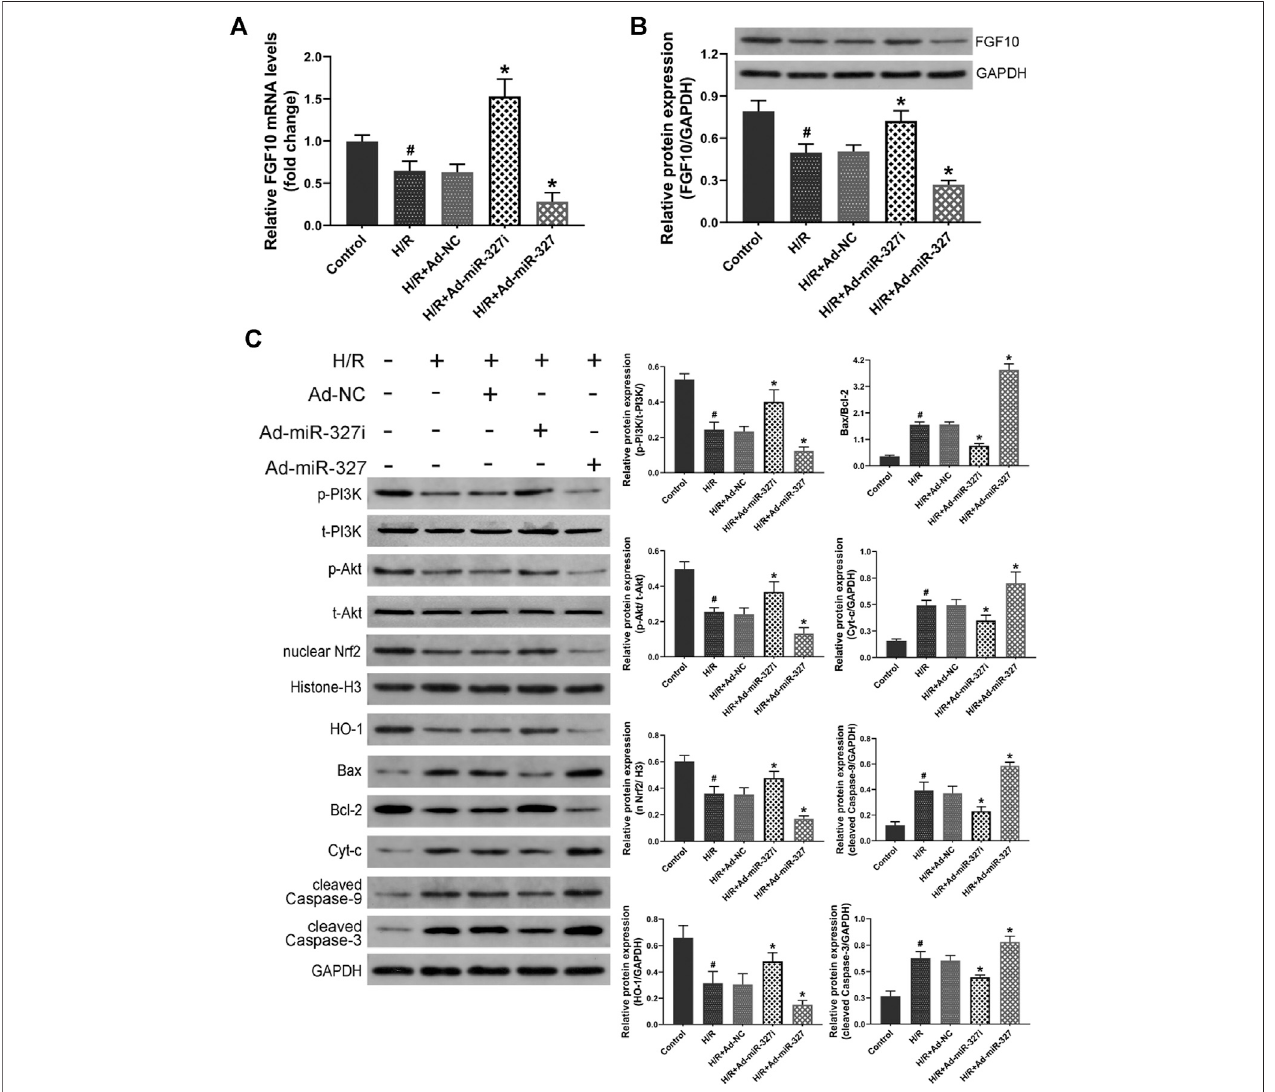
FIGURE3| Effects ofmiR-327ontheFGF10/Akt/Nrf2signalingpathway inH/RH9c2cells. FGF10mRNAandprotein levelsweremeasured bytheqRT-PCRand the Western blot (A-B) . FGF10 downstream protein p-PI3K and t-PI3K, p -Akt and t-Akt, antioxidant-related protein nucleus Nrf2 and HO-1, apoptosis-related protein Bax, Bcl-2, Cyt-c, cleaved caspase-9, and cleaved caspase-3 were detected by Western blot analysis in different groups of H9c2 cells (C) . Data are expressed as the mean ± SD ( n (cid:2) 3); # p < 0.05 versus the Control group; * p < 0.05 versus the Ad-NC group.